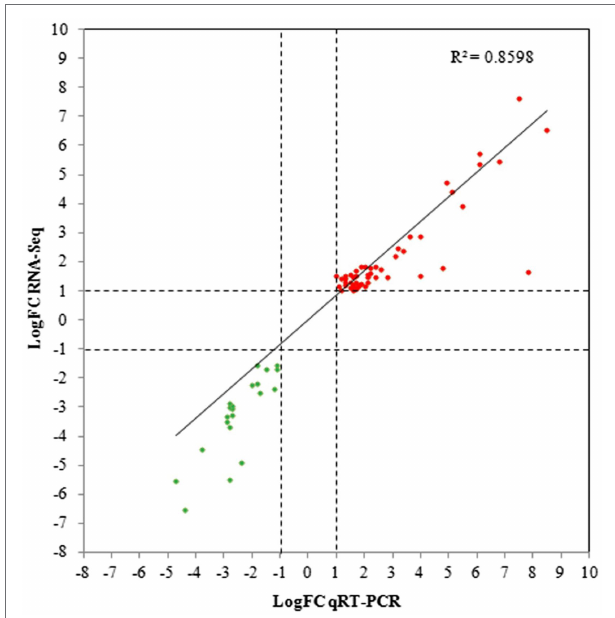
FIGURE 3 | Quantitative reverse-transcription PCR (qRT-PCR) validation for selected DEGs. Linear regression plots of the log Fold Change (logFC) obtained via RNA-Seq compared to qRT-PCR for 72 DEGs selected from the 3.5-h OLE treatment. Red dots represent upregulated genes whereas green dots represent downregulated